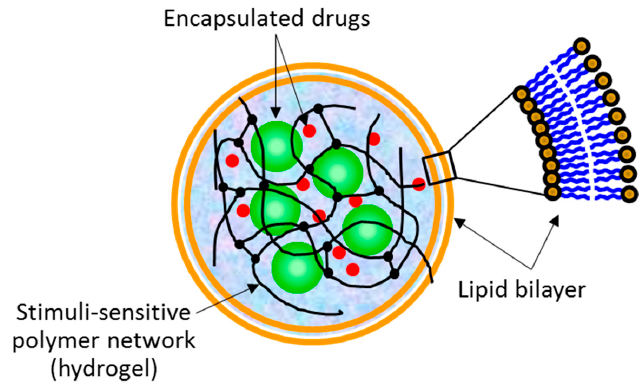
Figure 1. Schematic of the spherical lipid bilayer/hydrogel assemblies (lipobeads) with encapsulated drugs.